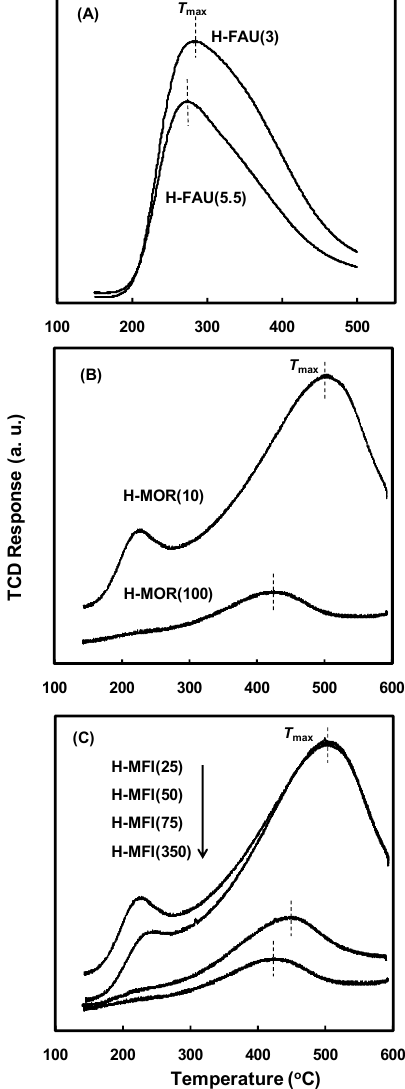
Figure 3. NH 3 -TPD profiles of H-FAU ( A ), H-MOR ( B ), and H-MFI ( C ) zeolite catalysts with different Figure 3. NH 3 ‐ TPD profiles of H ‐ FAU ( A ), H ‐ MOR ( B ), and H ‐ MFI ( C ) zeolite catalysts with different Si/Al molar Si/Al molar ratios.